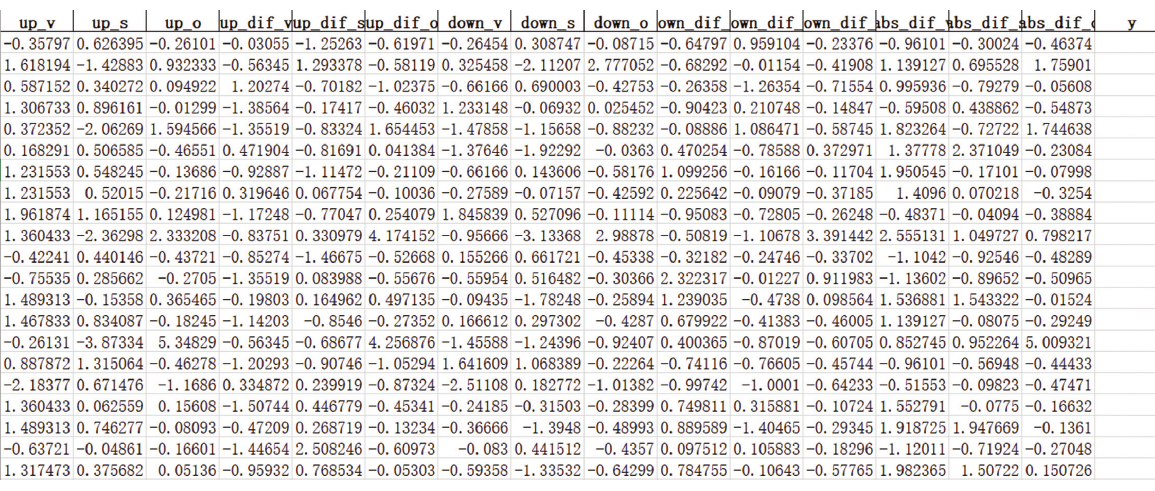
Figure 5: Low precision data set sample.